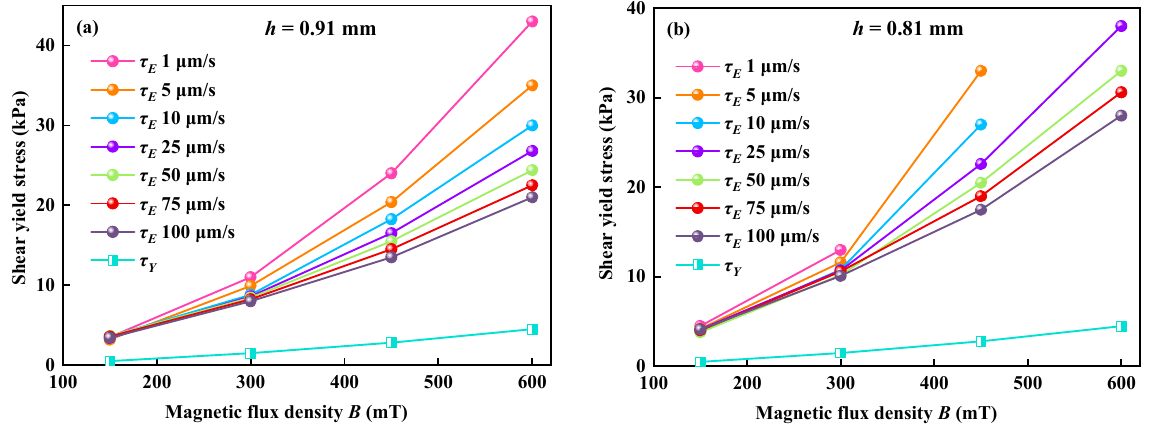
Figure 6. Comparison between normal shear-yield stresses yield and static shear-yield stresses under different compressive speeds and instantaneous gap distances. ( a ) h = 0.91 mm; ( b ) h = 0.81 mm. MR fluids are often considered viscoelastic material under high B [16,21]. The yield stress of MR fluids is usually used to indicate the degree of solidification under B .